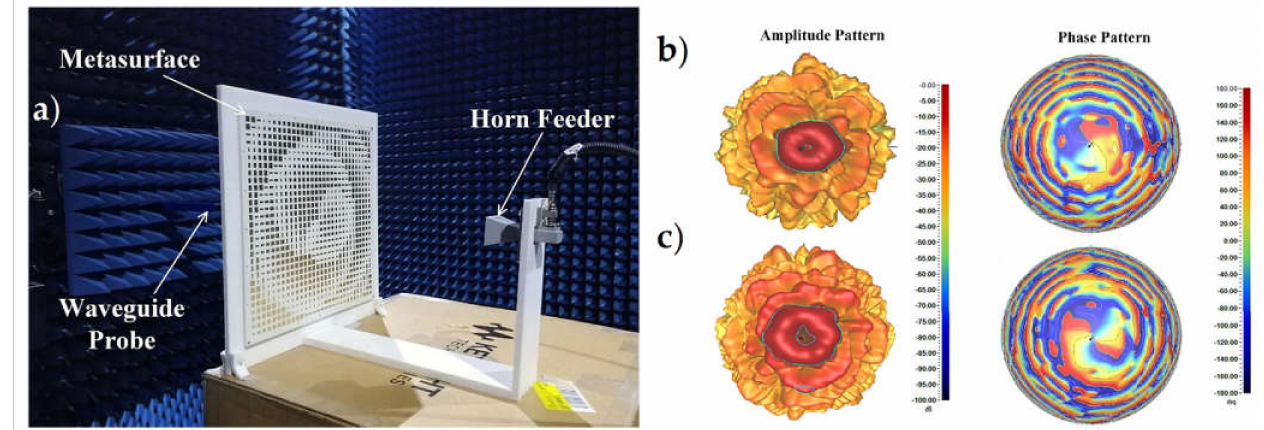
Figure 5. ( a ) The fabricated MS and its experimental setup with a WG probe in the near field chamber [126]. Radiation forms of the MS: ( b ) x-polarization, OAM mode l x = +1 [126]; and ( c ) y-polarization, OAM mode l y = − 2